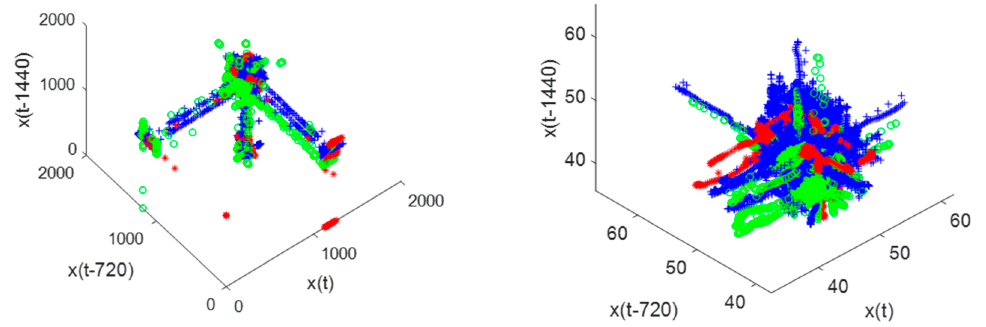
Figure 18. The reconstructed attractors of power draw ( left ) and outlet temperature ( right ) time series data with legend: fine (red ‘ ∗ ’), intermediate (blue ‘+’), and coarse (green ‘o’).